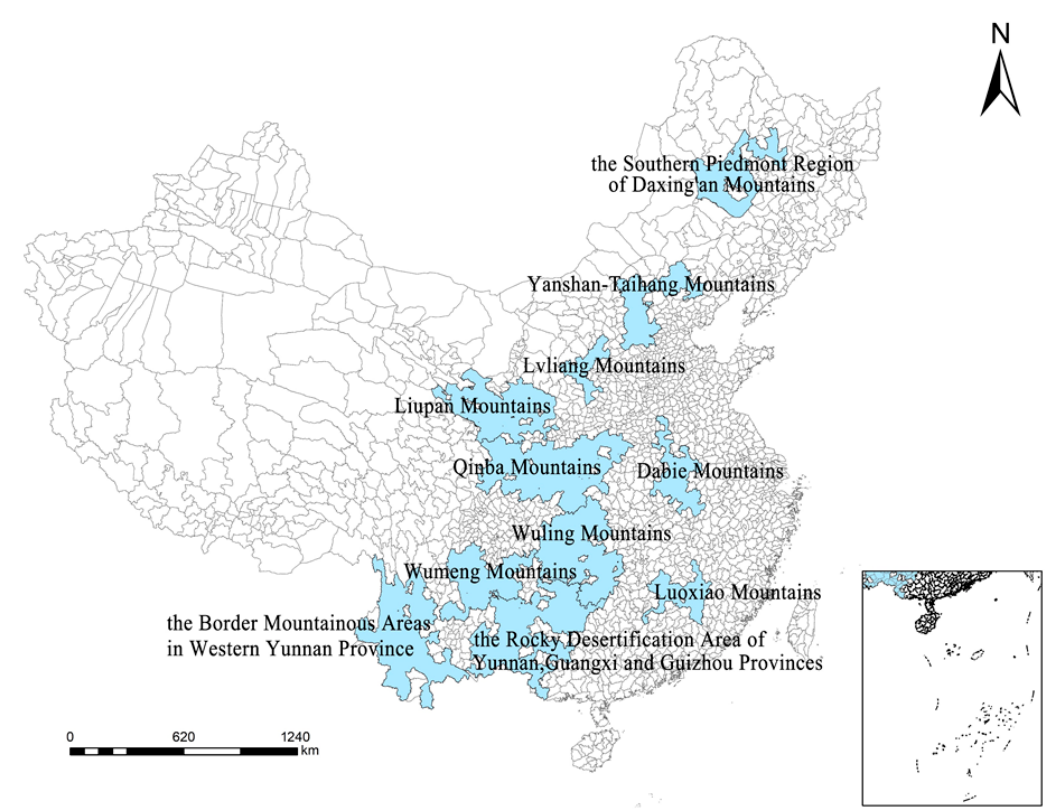
Figure 4. The spatial distribution of the 11 contiguous destitute areas in China.